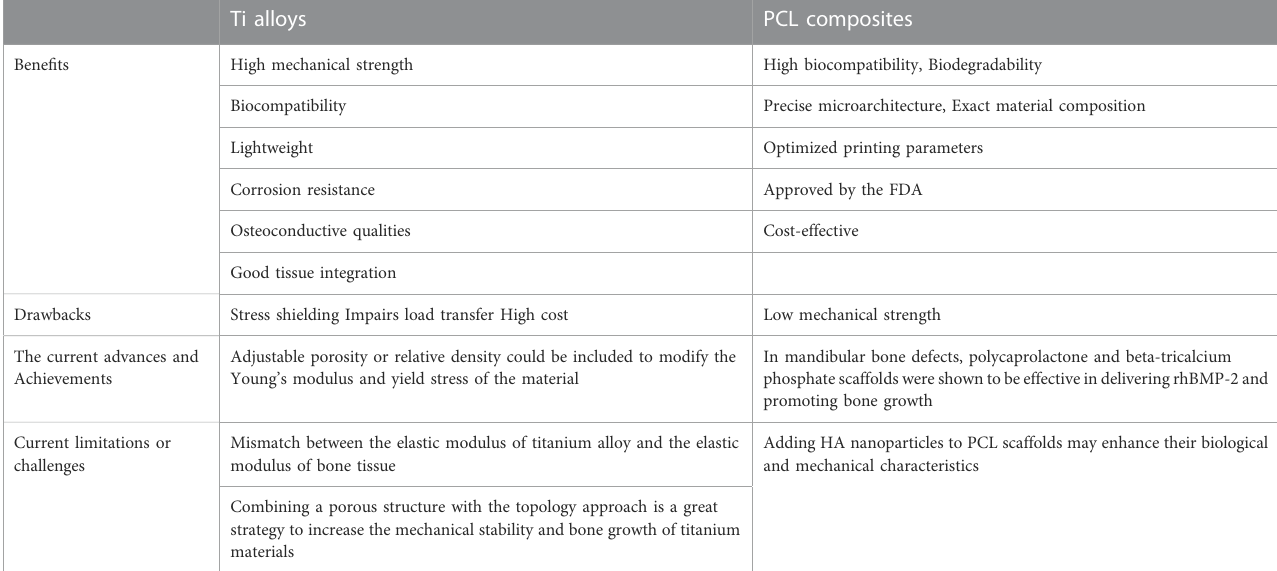
TABLE 5 Comparative summarize of PLC composite and Ti